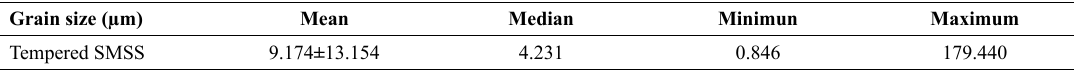
Table 3. Descriptive statistics of grain size data collected from EBSD data for tempered SMSS sample. Grain size (µm)